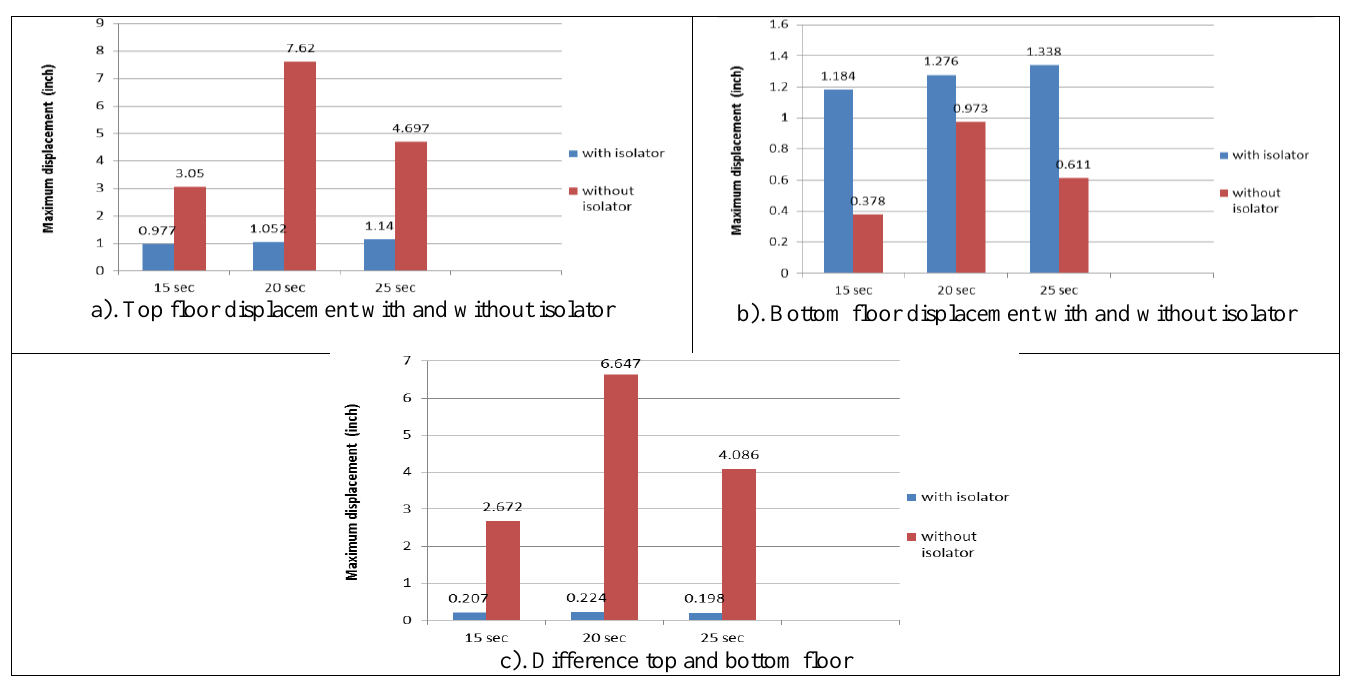
Figure 13: Displacement variation with and without isolator for different EL centro